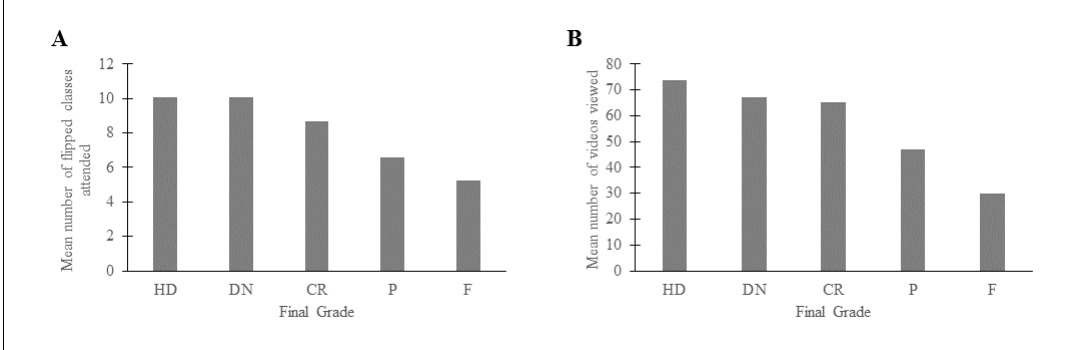
Figure 2: Engagement in the flipped classroom measured by attendance and online video views. A) The mean number of flipped classes attended over the semester was calculated for each grade category. B) The mean number of videos watched over the semester was calculated for each grade category. HD=High Distinction (85≥), DN=Dist inction (75- 84), CR=Credit (65 - 74), P=Pass (50 - 64), F=Fail